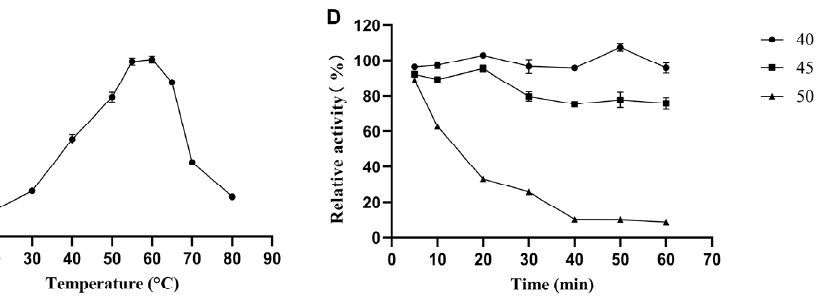
Figure 2. Biochemical characterization of the purified recombinant pePGA. ( A ) The effect of pH on enzyme activity. The enzyme activity was measured at 55 °C in 20 mM Na 2 HPO 4 ‐ citric acid buffer from 3.0 to 8.0. ( B ) pH stability of pePGA. The enzyme was incubated in 0.2 M Na 2 HPO 4 ‐ citric acid buffer with different pH (3.5–8.0) at 25 °C for 1 h and the residual activities were determined under the standard condition. ( C ) The effect of temperature on enzyme activity. The enzyme activity was measured at temperatures ranging from 20 to 80 °C in a 50 mM pH 6.0 Na 2 HPO 4 ‐ citric acid buffer. ( D ) Temperature stability of pePGA. The enzyme was incubated at 40 °C, 45 °C and 50 °C in a 50 mM pH 6.0 Na 2 HPO 4 ‐ citric acid buffer for various periods, and the residual activities were determined under the standard condition. Error bars present the standard deviation ( n = 3).